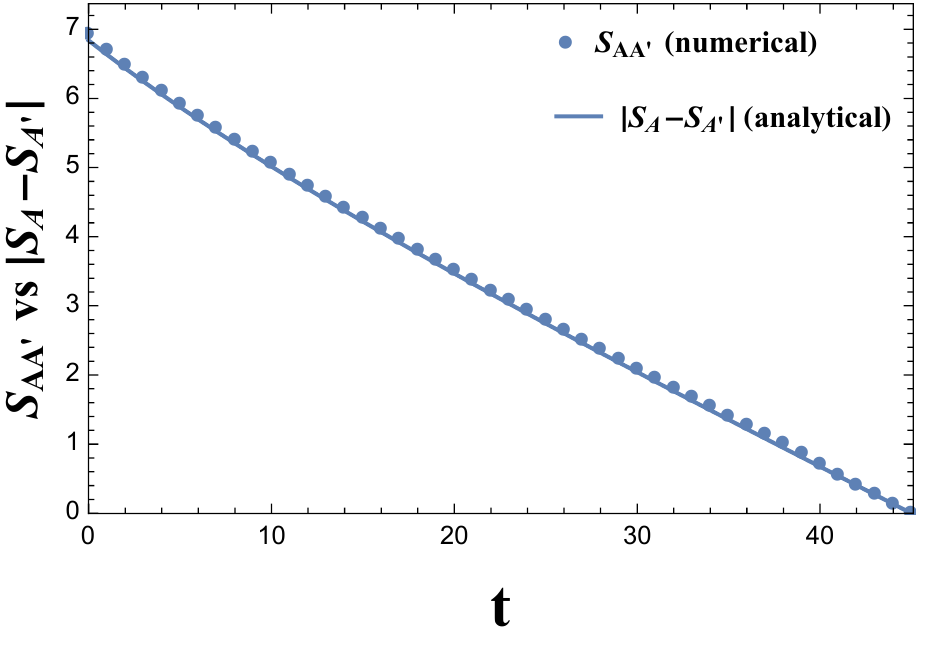
Figure 5 . A numerical plot of S AA 0 (blue dots) and an analytical plot of | S A ( t ) − S A 0 ( t ) | (blue line) for the choice of g ( t ) given by eq. (3.11), (3.20). where (cid:15) 0 = 1 . 0 × 10 − 2 . As an initial condition, we took M 0 A = 100 , M 0 A 0 = 10 , with α = 1 . In this plot, we set 4 G N = 1